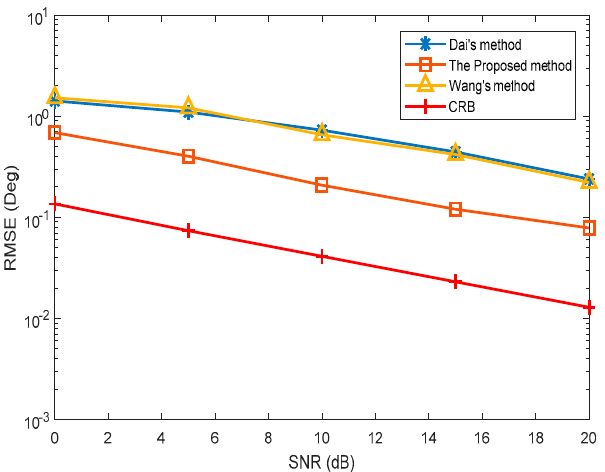
Figure 2. The root mean square error (RMSE) versus signal to noise ratio (SNR) for different methods ( M = 8 and T = 300).